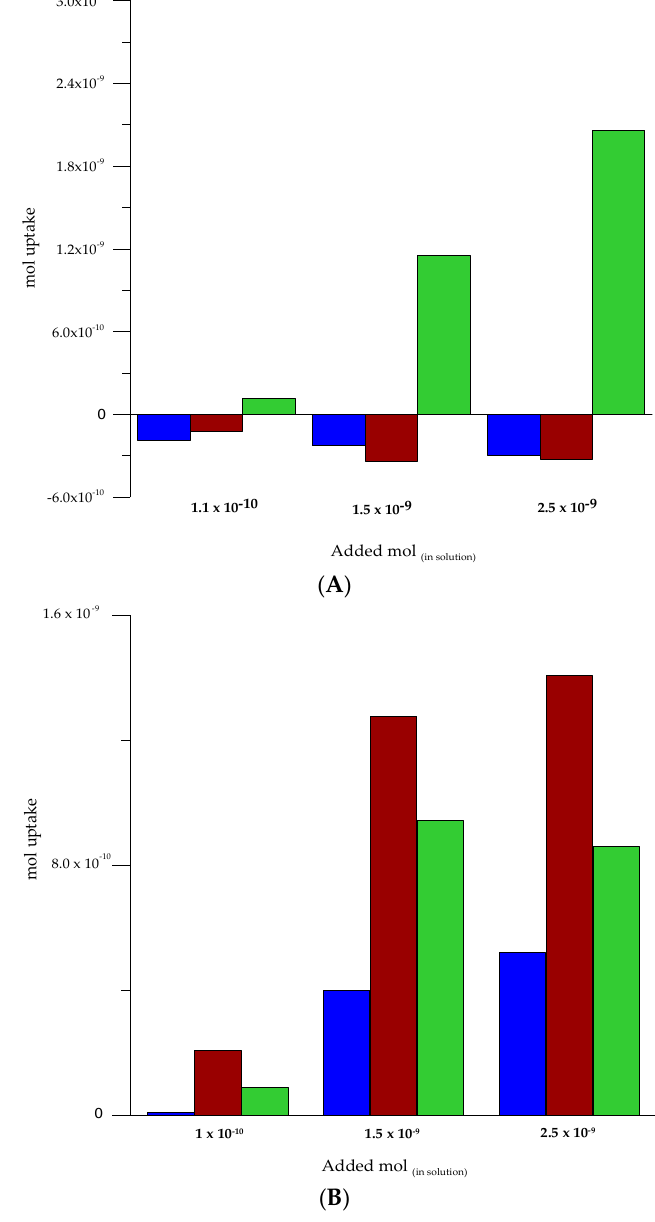
Figure 6. ( A ) cMIP from 5-pOH-DP/Acetyl-HS. Rebinding test vs. Acetyl-HS (red bar) and selectivity assessment vs. Cbz-HS (blue bar) and α-acetylbutyrolactone (green bar); ( B ) cMIP from 5-pOH-DP/Cbz-HS. Rebinding test vs. Cbz-HS (blue bar) and selectivity assessment vs. Acetyl-HS (red bar) and α-acetylbutyrolactone (green bar).